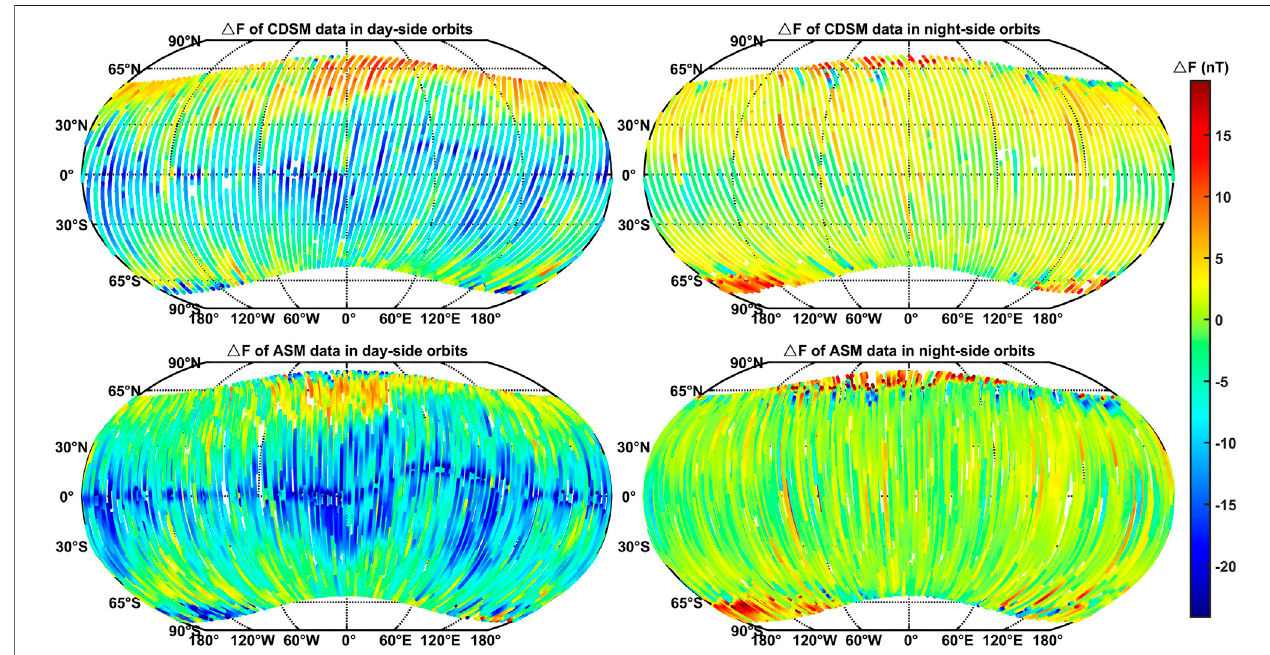
FIGURE 5 | Distribution of Δ F from 31 July 2019 to 30 September 2019 in geographic reference frame for CDSM and ASM selected data.